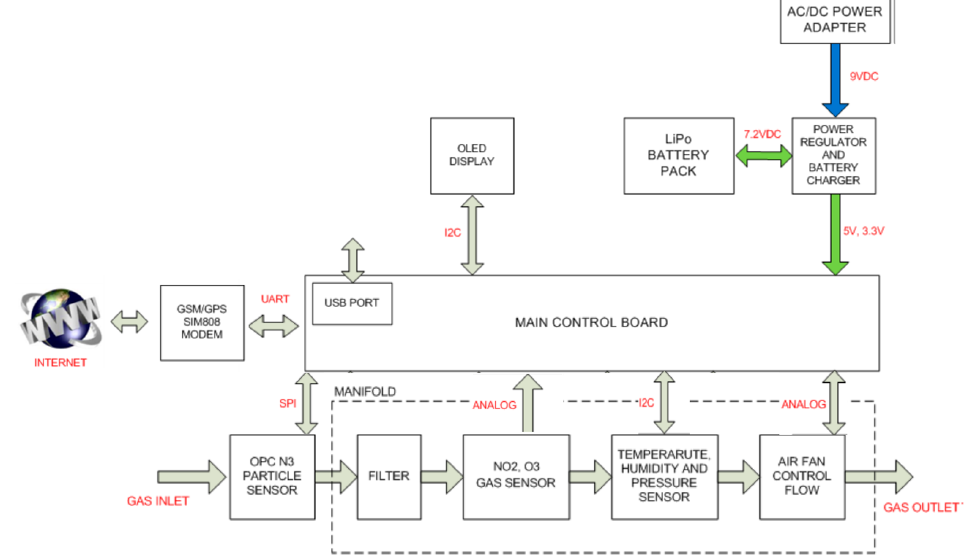
Figure 1. General diagram of device.